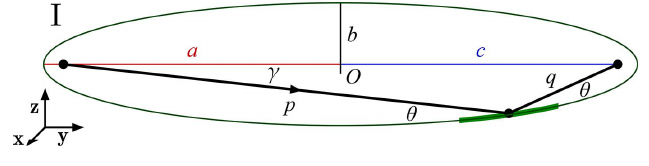
Figure 3 Cross-section of the Type I ellipsoid in the yz plane, centered on the coordinate origin, O . The direction of light propagation is indicated.